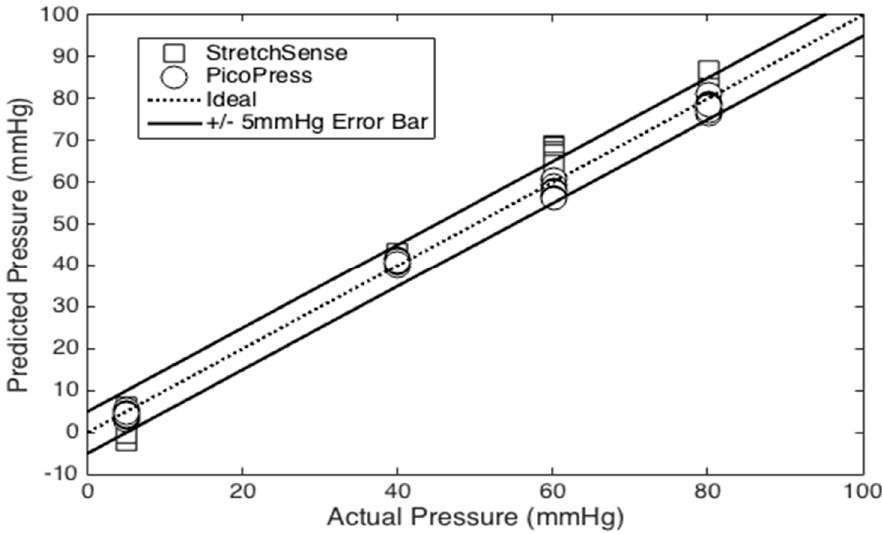
Figure 16. Experimental comparisons of StretchSense and PicoPress sensors.